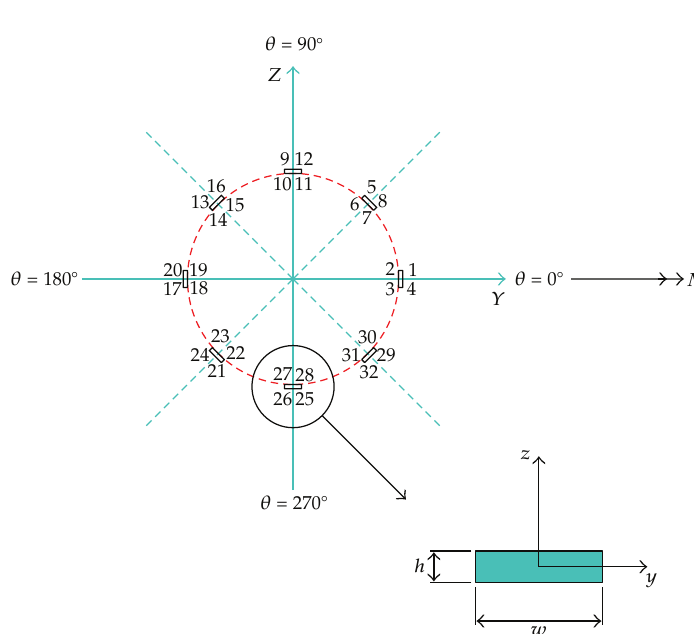
Figure 5: Tensile armor wires in a cross-section of a flexible